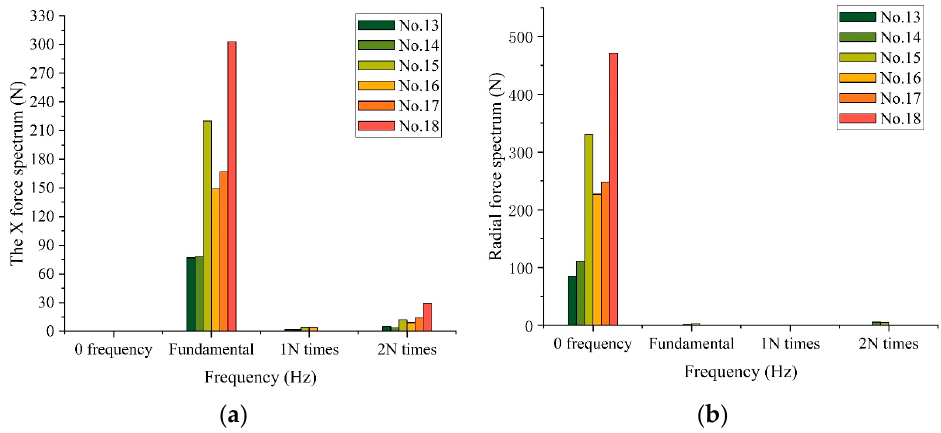
Figure 13. Frequency spectrum analysis of boring cutting load. ( a ) Force in X-direction. ( b ) Resultant force in radial direction.